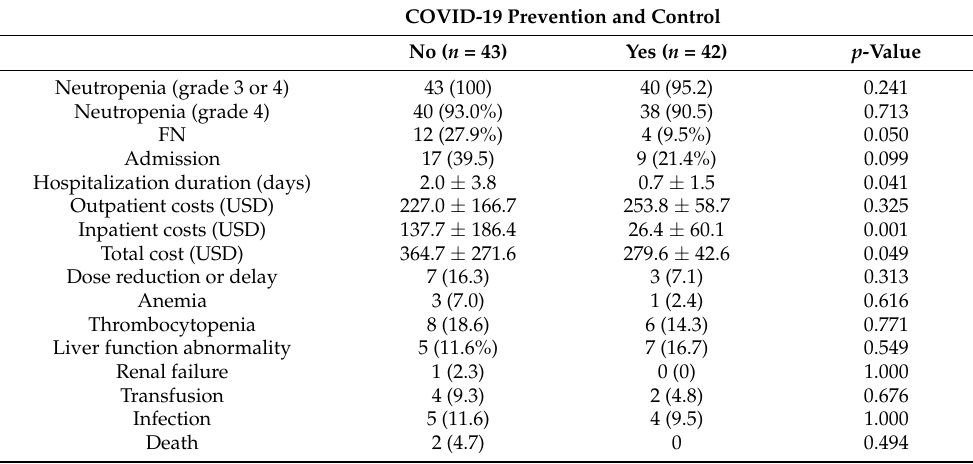
Table 2. Incidence of chemotherapy-related adverse events and hospital costs. Data expressed as numbers and percentages